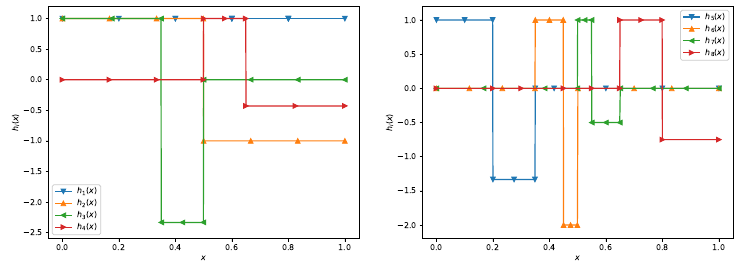
Figure 1. Haar wavelets on a nonuniform grid for J = 2 as described by